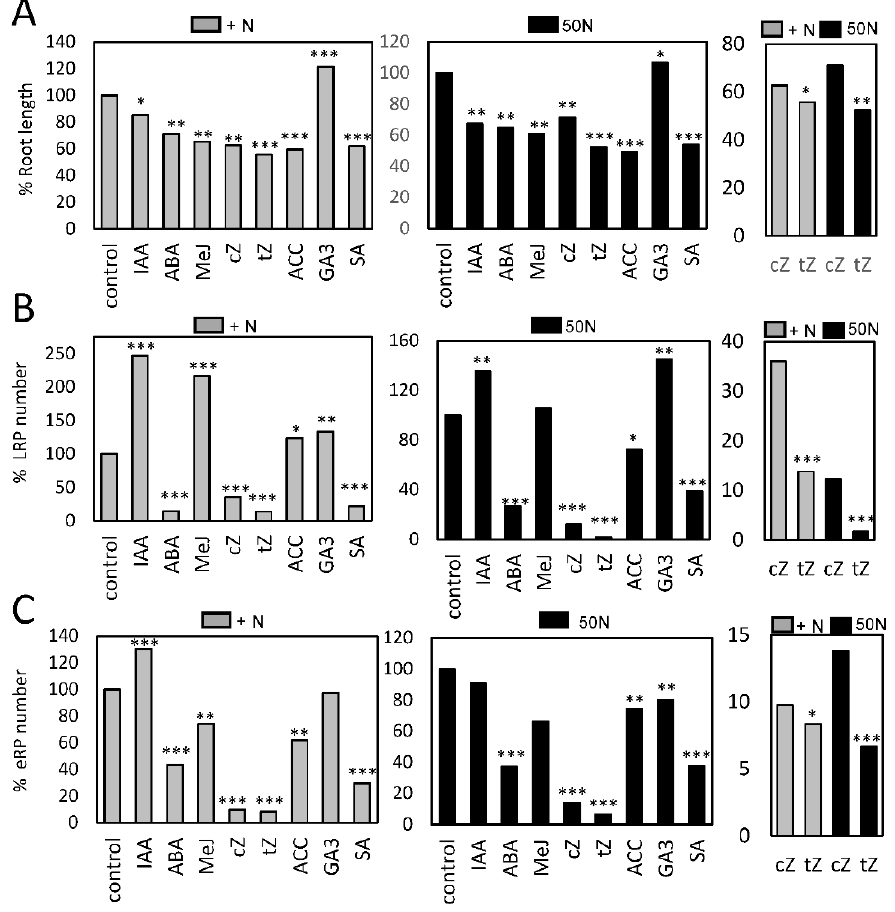
Figure 4. E ff ect of phytohormones on root growth and LR formation during N starvation. Dark-root growth Arabidopsis seedlings were grown with high (grey boxes) or low (black boxes) nitrogen for 5 days and then transferred to fresh medium containing similar N content and di ff erent hormones for 5 more days. Root length ( A ), lateral root primordia (LRP) ( B ) and eLRs ( C ) were quantified. Graphs represent the percentage of hormone-treated seedlings in respect to non-treated. *, p < 0.05; **, p < 0.01; ***, p < 0.001 by t -test compared to the respective control (mock) and nitrogen level. Right graphs show a magnification of the cZ and tZ e ff ects. In this case, the significance was analyzed by t-test comparing the e ff ect between cZ and tZ.